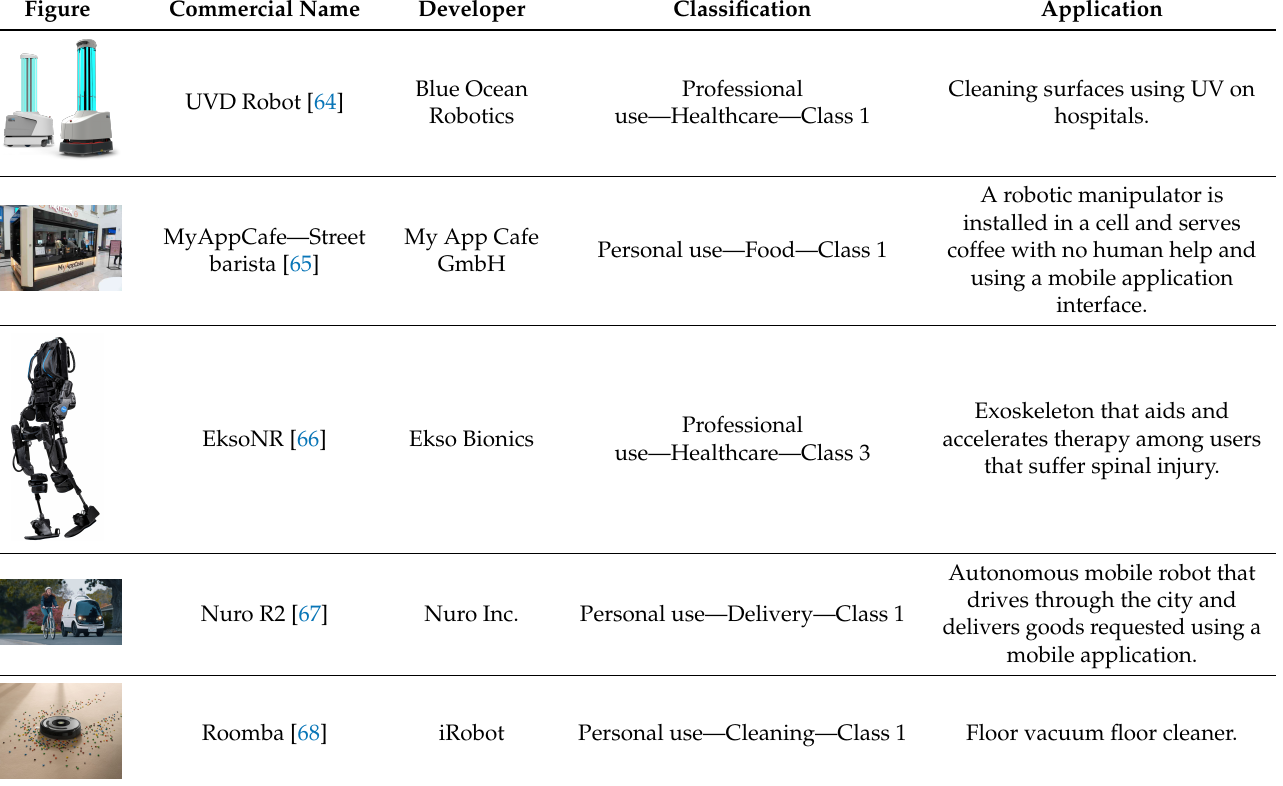
Table 2. Sample commercial service